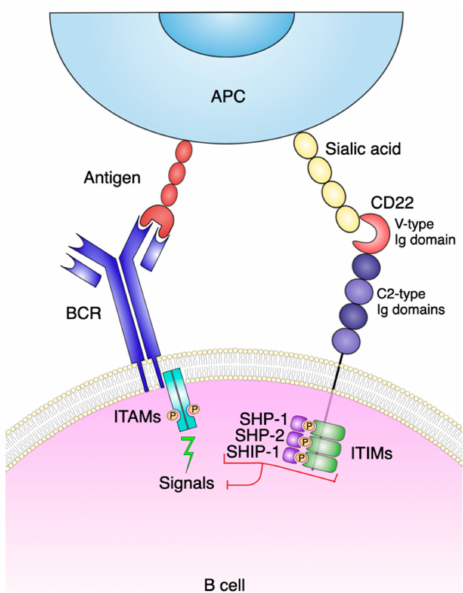
Figure 3. Structure, interactions, and biological activities of human CD22. The structure of the molecule includes an extracellular domain (six C-type and one V-type immunoglobulin domain). The intracellular domain encompasses immunoreceptor tyrosine-based inhibitory motifs (ITIMs). When sialic acids expressed by antigen presenting cells (APC) bind to CD22, the tyrosine residues of the ITIMs are phosphorylated. Ligation of the phosphorylated ITIMs to Src homology region 2 domain-containing phosphatase-1 and -2 (SHP-1 and SHP-2) and to Src homology region 2 domain-containing inositol phosphatase-1 (SHIP-1) induces a down-regulation of BCR-mediated